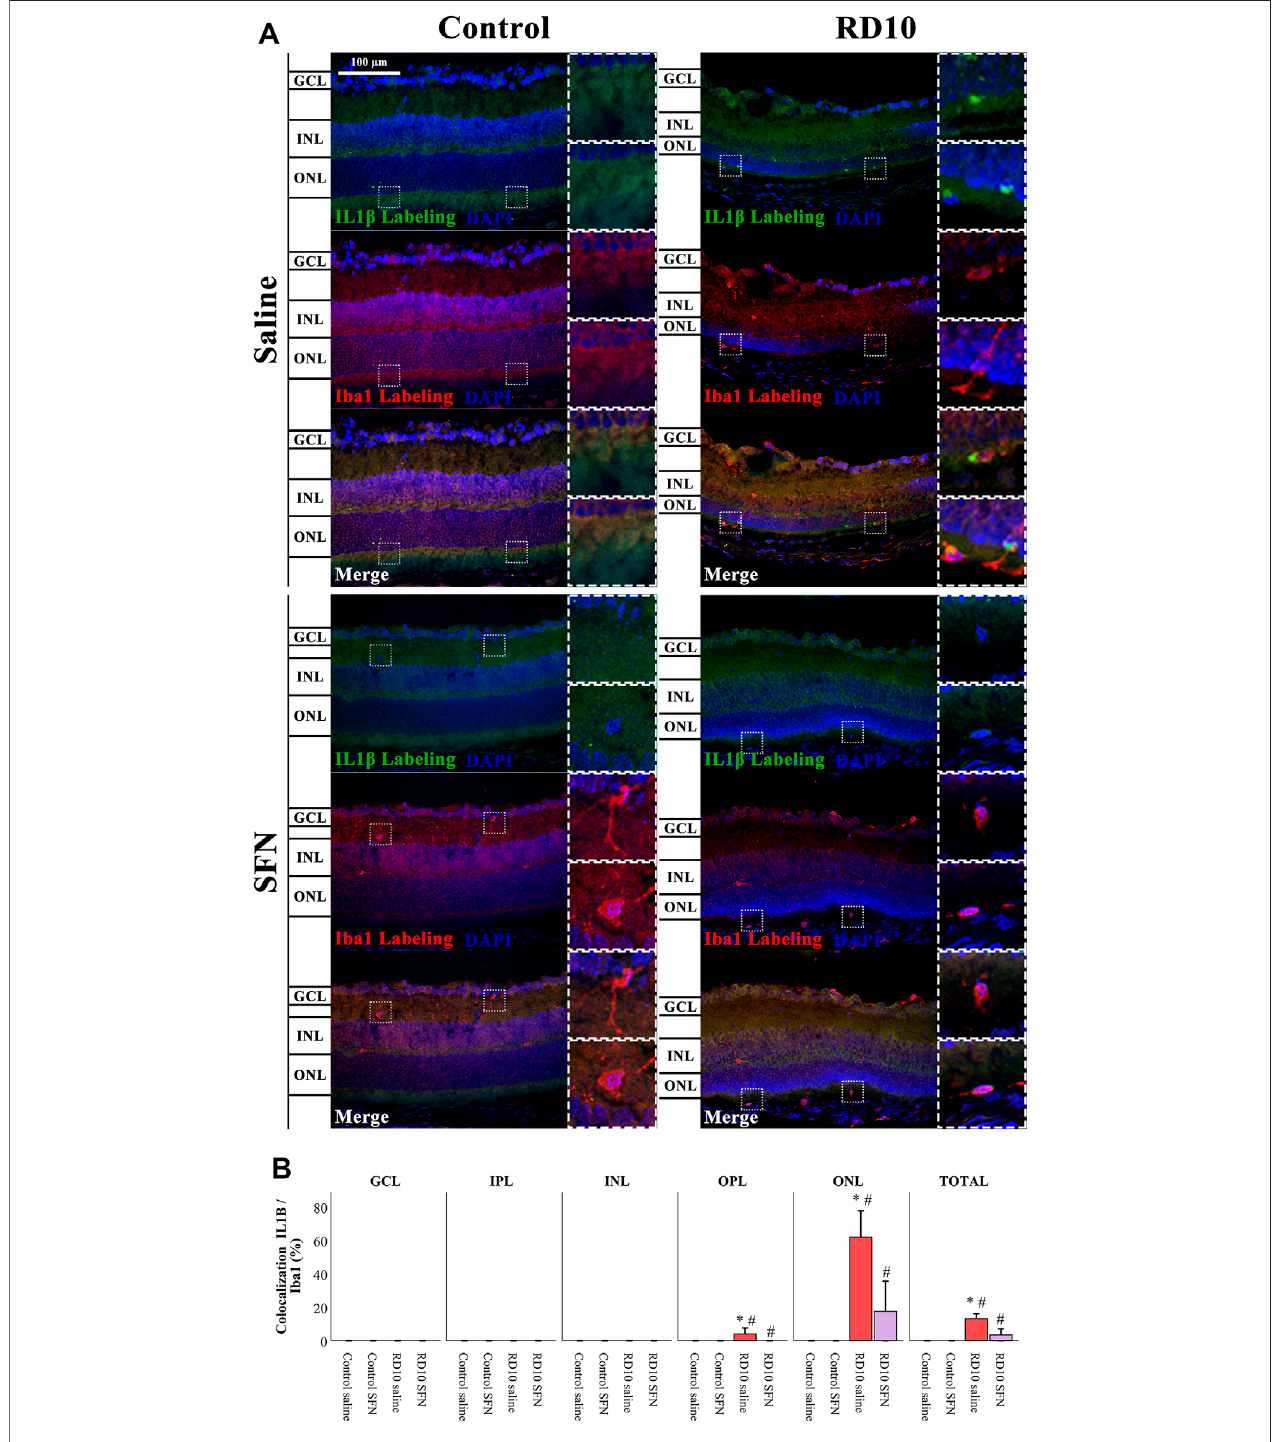
FIGURE 8 | IL1 β -Iba1 expression assessment. (A) Nerve region images of IL1 β -Iba1 immuno fl uorescence of the different groups in the experiment. (B) The percentage of IL1 β -Iba1 colocalization was calculated regarding Iba1 total expression. *Differences between Control Saline vs. RD10 Saline or Control SFN vs. RD10 SFN ( p -value < 0.05). #Differences between RD10 Saline vs. RD10 SFN ( p -value < 0.05).